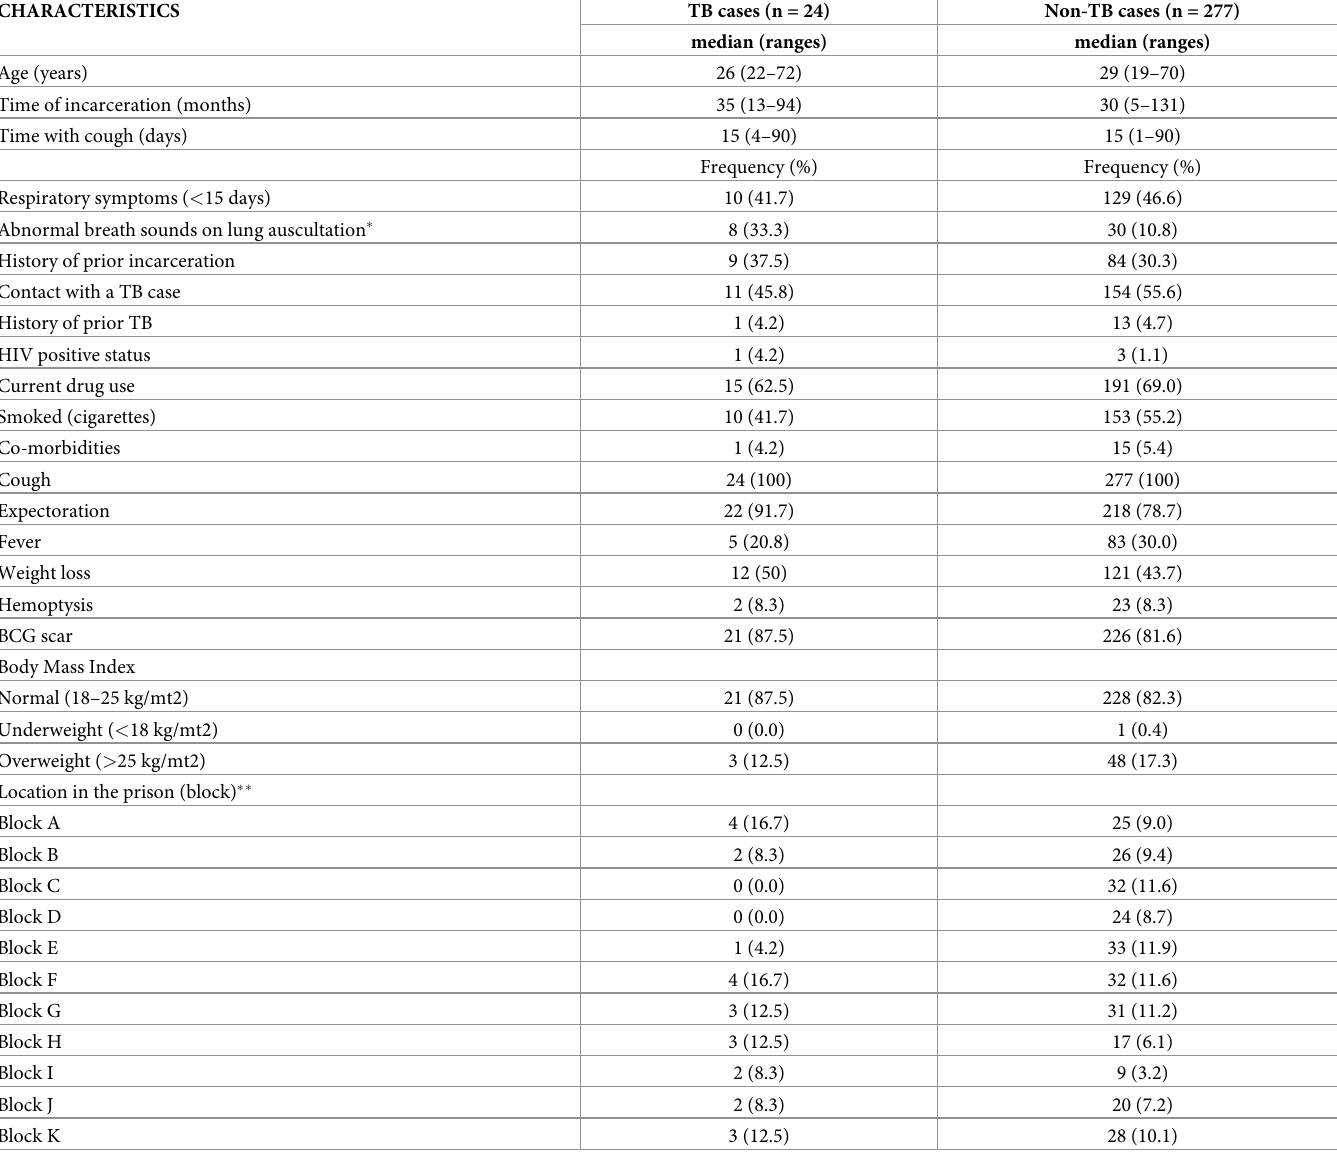
Table 2. Baseline characteristics of inmates with respiratory symptoms of any